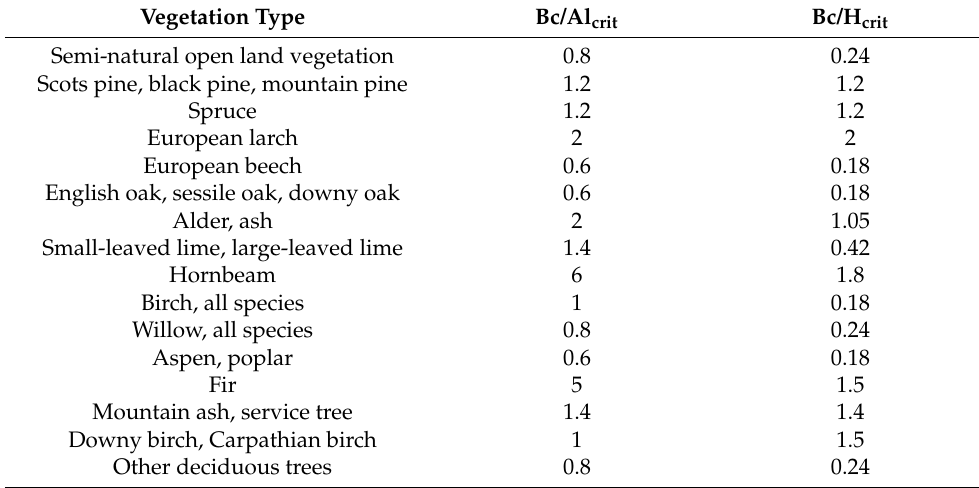
Table 3. Vegetation-dependent critical ratios of basic nutrient cations to aluminum and protons [92]. Vegetation